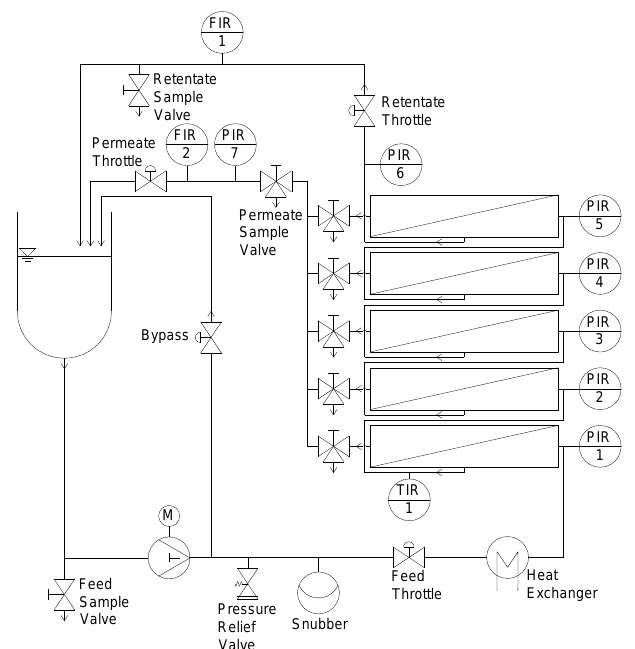
Figure 2. Filtration plant equipped with the filtration unit.